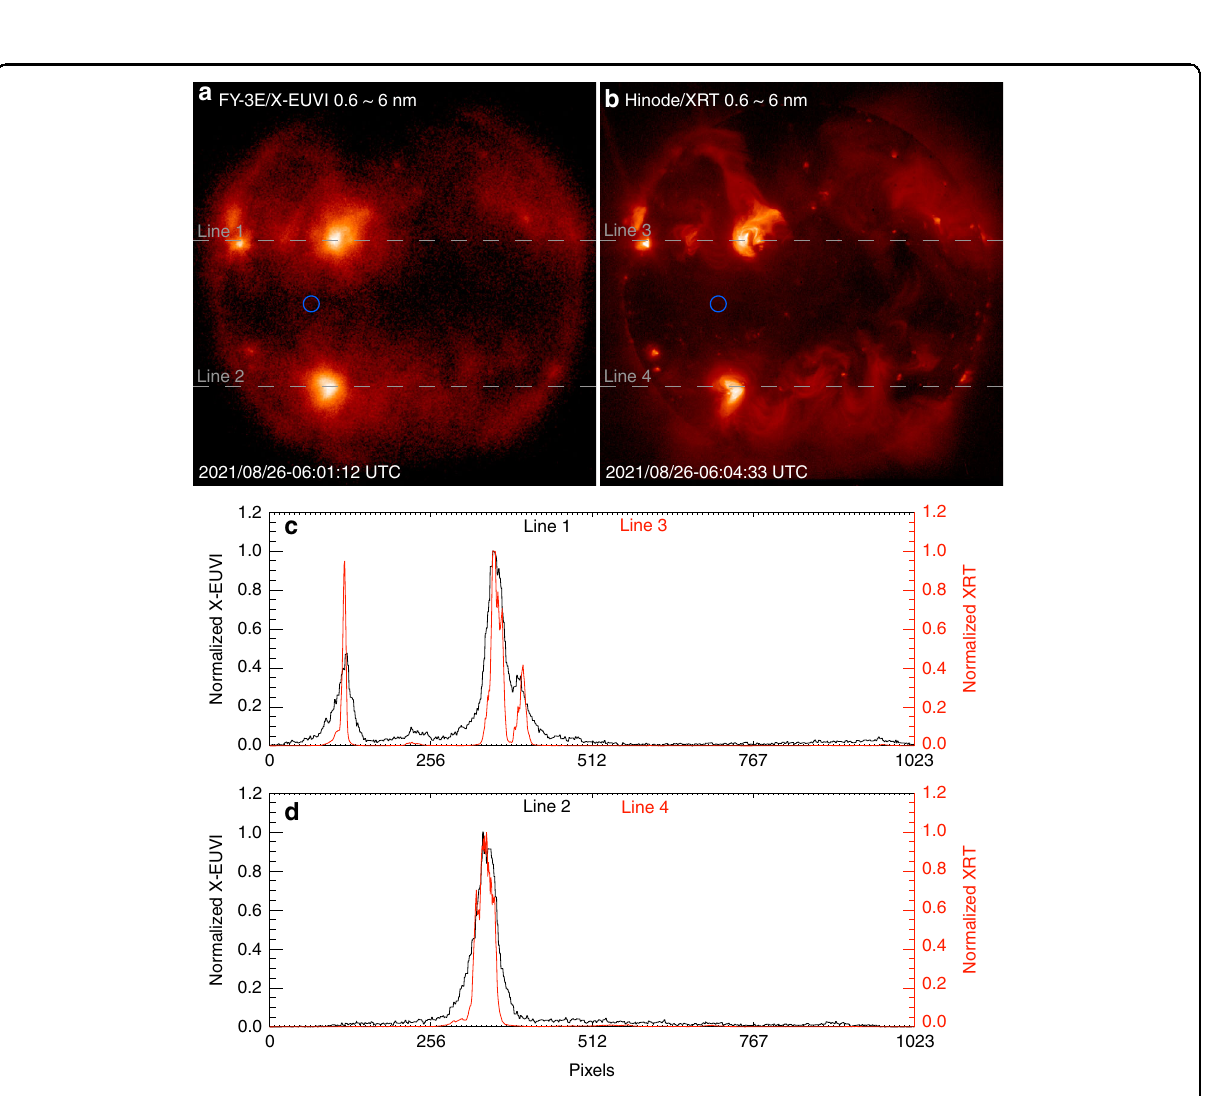
Fig. 7 Comparison of X-ray images from X-EUVI and XRT. a The positions of line 1 and line 2 from X-EUVI. b The positions of line 3 and line 4 from XRT. c The normalized grey value distributions of line 1 and line 3. d The normalized grey value distributions of line 2 and line